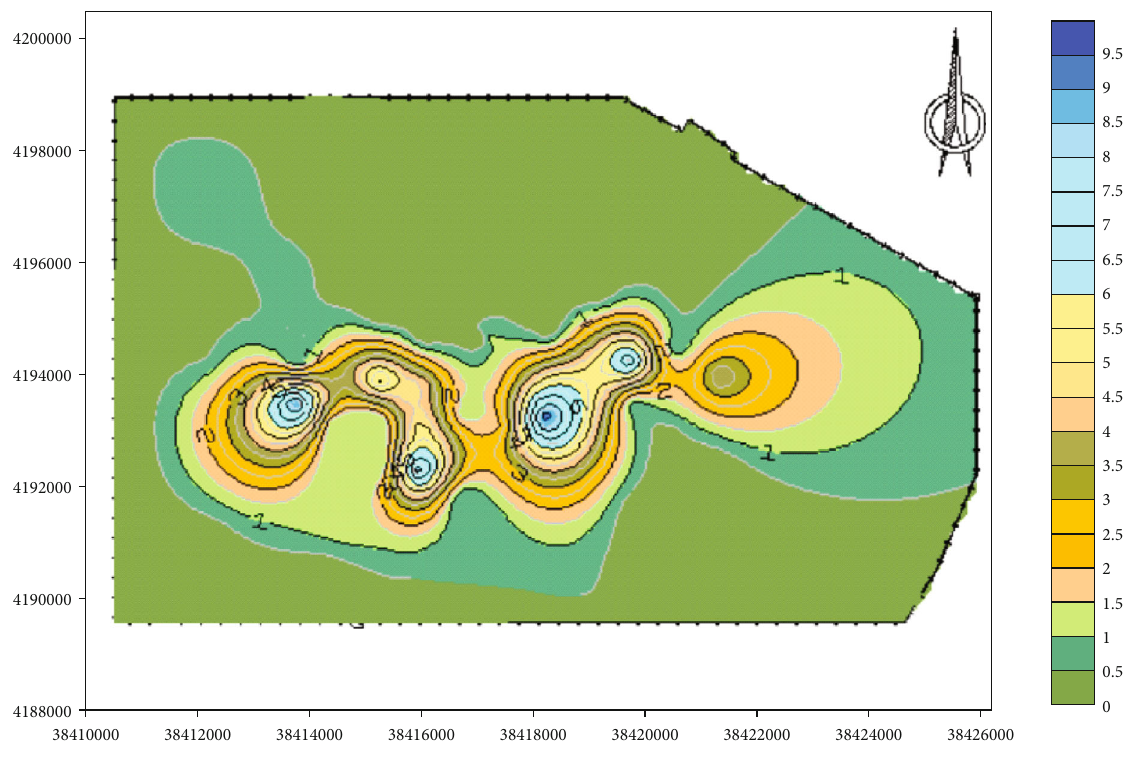
Figure 5: Thematic map of K